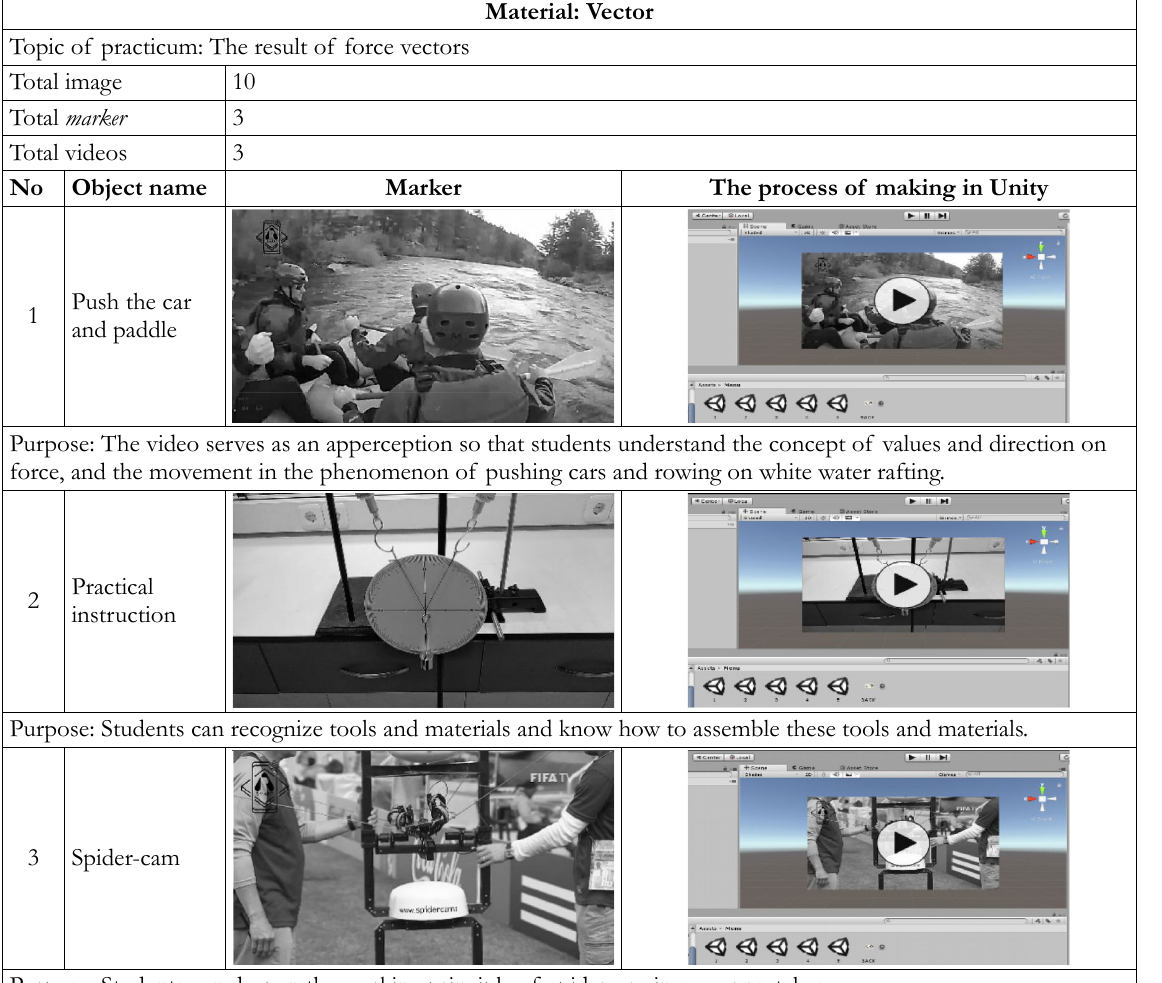
Table 2. The details of video